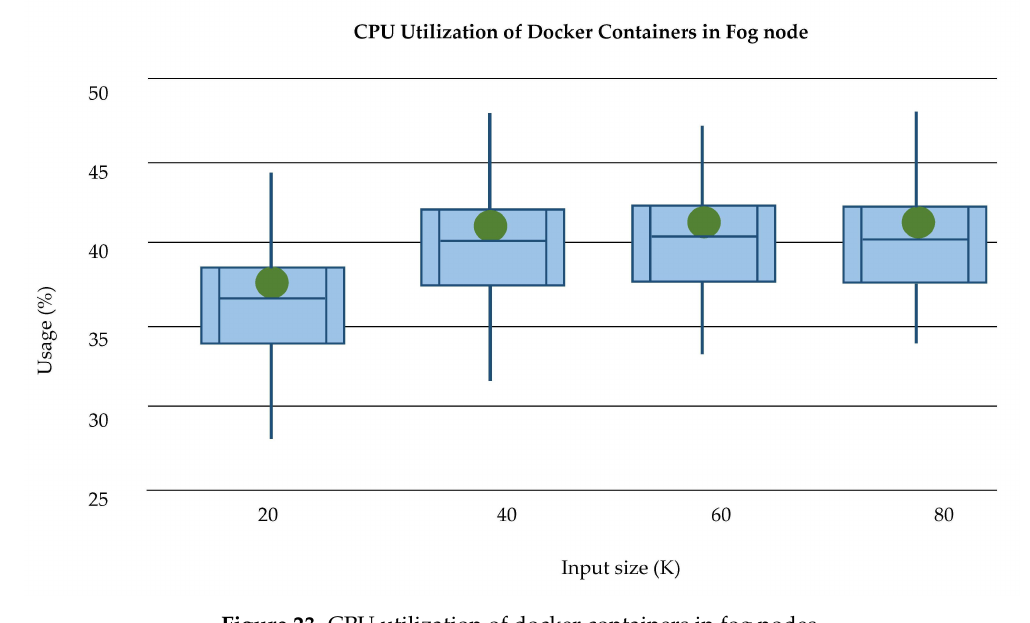
Figure 23. CPU utilization of docker containers in fog nodes.